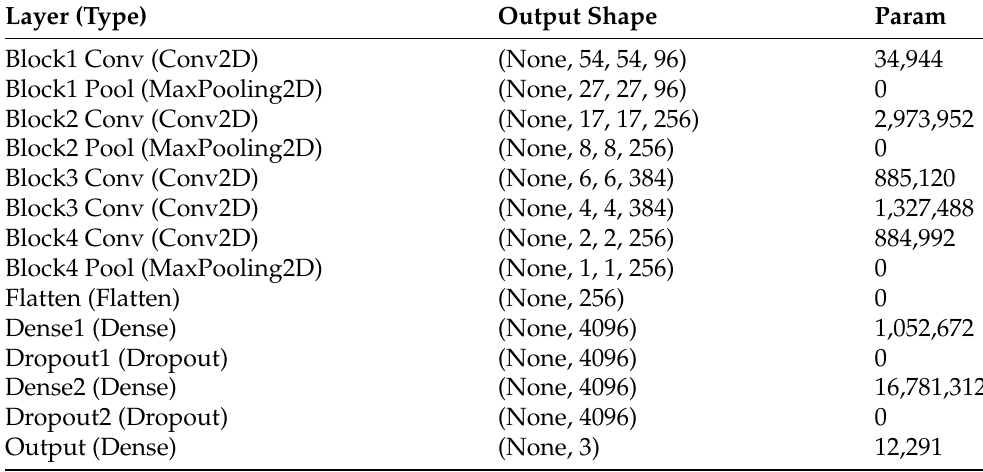
Table A2. Architecture of the AlexNet.